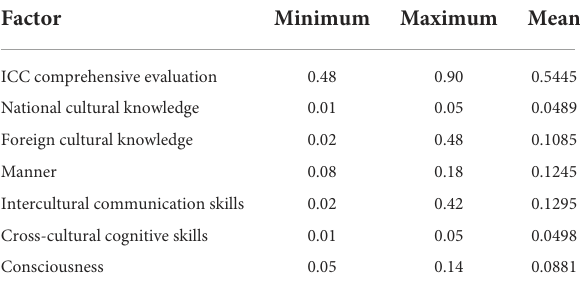
TABLE 5 Comprehensive evaluation of cross-cultural competence of 170 college